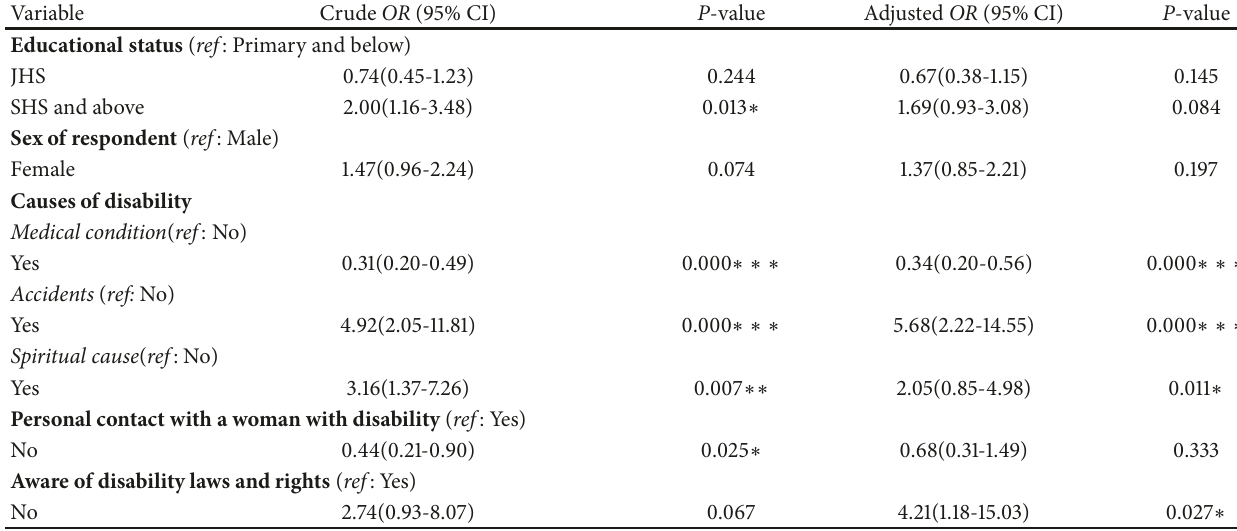
Table 6: Logistic Regression of factors influencing attitudes towards pregnant women with